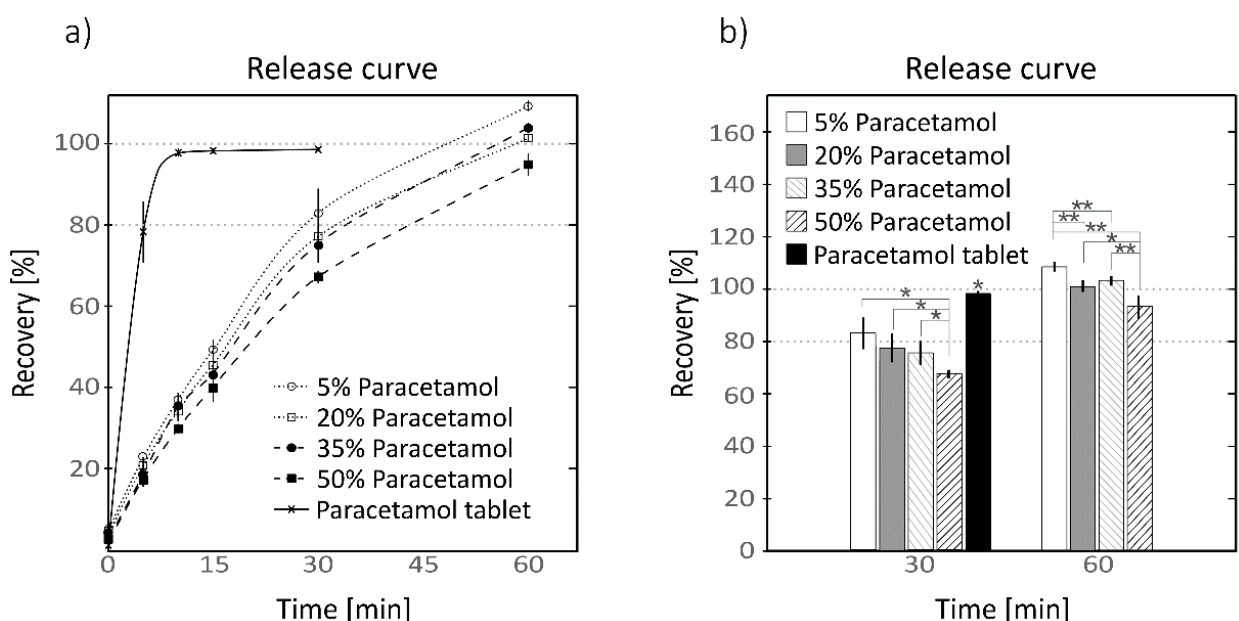
Figure 3. Release curve of extruded mixtures ( a ) containing 5% wt of Guar gum and different proportions of paracetamol and commercial paracetamol tablet at different sampling times; detail ( b ) of recovery values at 30 and 60 min in bar chart showing the statistical significances. Dotted line with hollow circle and solid white columns, mixture with 5% wt of paracetamol; dotted line with hollow squares and grey columns, 15% wt; dashed line with solid circle and grey stripped columns, 35% wt; and dashed line with solid squares and black striped columns, 50% wt. Continuous line with crosses and solid black column, recovery percentage of the paracetamol tablet. Horizontal axis represents the time bar in minutes and vertical axis the % rate of recovery measured with HPLC-DAD (mean ± SD, n = 3, * p < 0.05, ** p < 0.01). At minute 0, all the samples, including the paracetamol tablet, showed a burst release of 5%, the mixture with 5% wt paracetamol showing the highest value of (4.7 ± 1.2%).